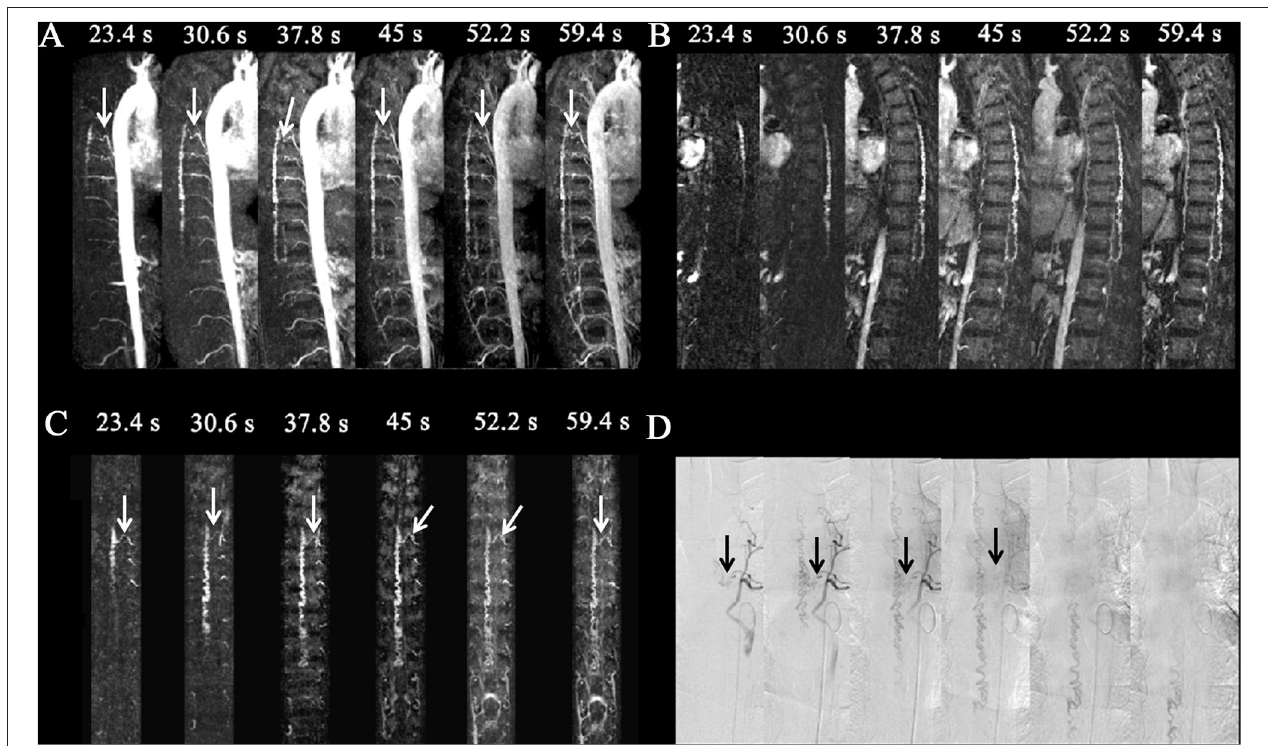
FIGURE 2 | Spinal dural arteriovenous fistula (SDAVF) in a 46-year-old patient. Comparison of visualization capabilities of magnetic resonance angiography and digital subtraction angiography (DSA). (A) The dynamic sagittal maximum intensity projections (MIPs) of the time-resolved angiography with stochastic trajectories (TWIST) examination. The feeding artery and fistula (T6, white arrows) were displayed clearly, and the length of the dilated vein was gradually expanded. (B) The dynamic target sagittal MIPs of the TWIST examination. The length of the dilated vein was clearly displayed. (C) The dynamic target coronal curved planar reformation MIPs of the TWIST examination. The feeding artery and fistula (T6, left, white arrows) were displayed clearly. (D) DSA was performed, which confirmed the diagnosis of SDAVF with a level of the feeding artery of T6 (left, black